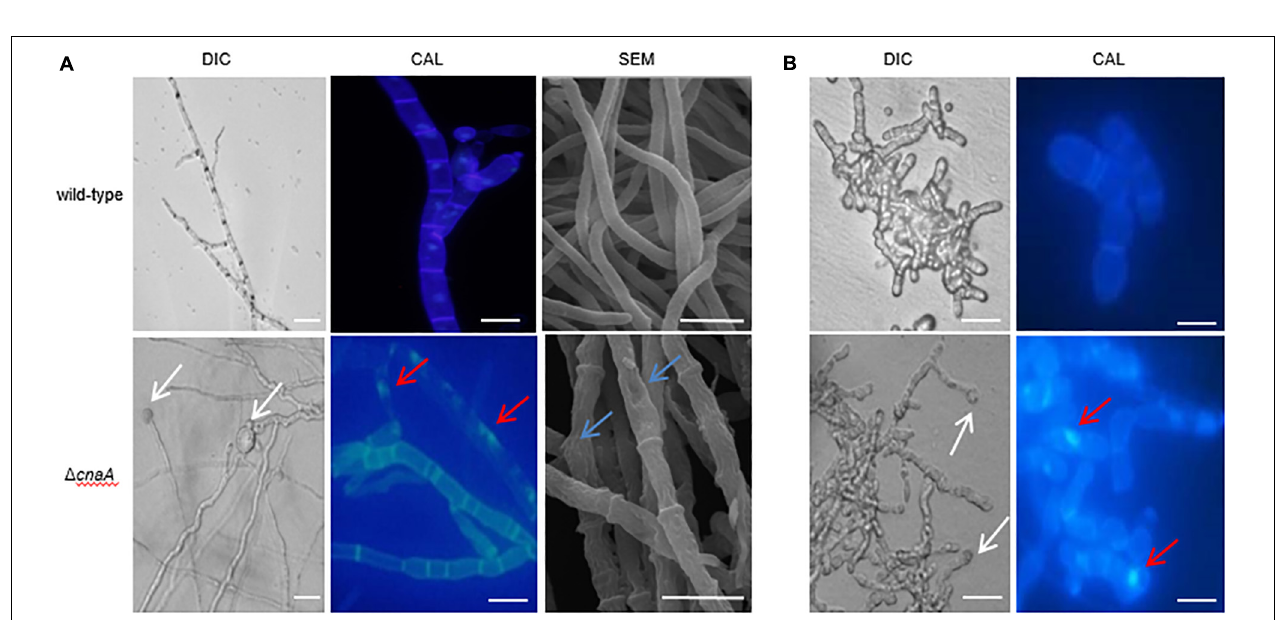
FIGURE 3 | The cnaA mutant displays defects in hyphal and yeast morphogenesis. (A) Wild-type and (cid:49) cnaA strains were inoculated onto ANM medium and grown at 25 ◦ C for 10 days, followed by either staining with calcofluor to visualize cell walls by light microscopy or SEM. The wild-type hyphal cells showed a smooth and uniform hyphal diameter with regular septation and uniform staining with calcofluor white. In contrast, the (cid:49) cnaA mutant showed irregular hyphal growth with enlarged cells (white arrow) and exhibited abnormal chitin deposits along the hyphae (red arrow). SEM images show that the mutant hyphal cells appear shrunken and irregularly shaped with very prominent septa. (B) The terminal ends of yeast cells of the (cid:49) cnaA mutant were swollen (white arrow) and exhibited abnormal chitin deposits (red arrow). Scale bars, 10 µ m.